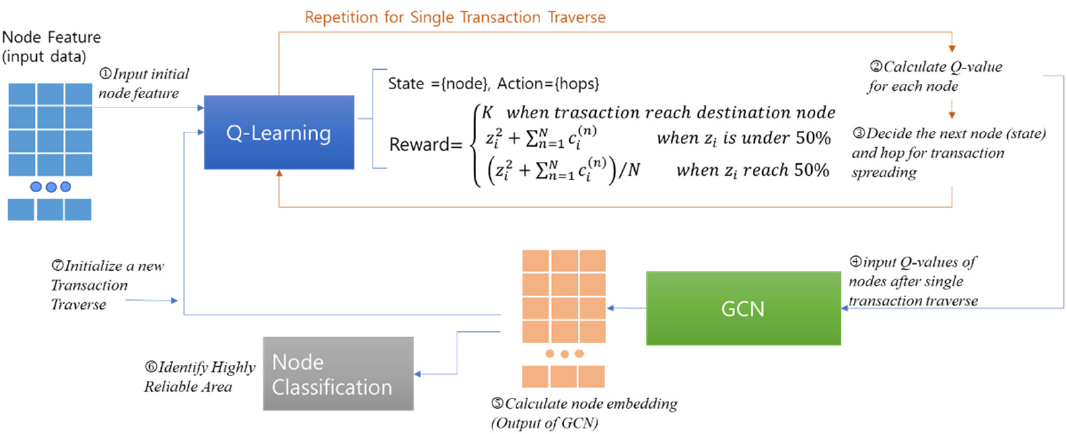
Figure 3. Concatenation of Q ‐ Learning and GCN for finding Node Reliability.